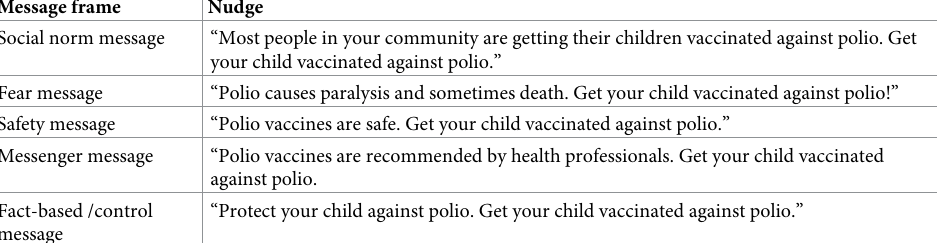
Table 2. Message frames and